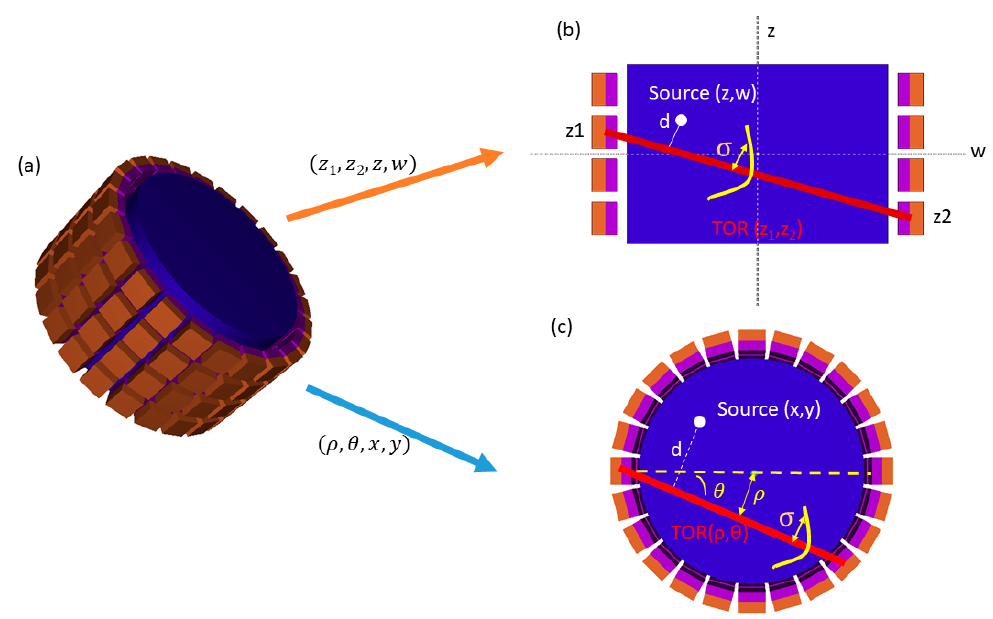
Figure 1. ( a ) 3D Positron emission tomography (PET) scanner and computation of system response matrices (SRMs). ( b ) Axial SRM. A source placed in position ( z , w ) in the rebinned data space, can produce a coincidence in a tube of response (TOR) ( z 1 , z 2 ) of width σ . The probability depends on the distance d from the source to the line of response (LOR). ( c ) Transaxial SRM. A source placed in position (x,y) in the field of view can produce a coincidence in a TOR ( ρ , θ ) of width σ . The probability depends on the LOR–source d.